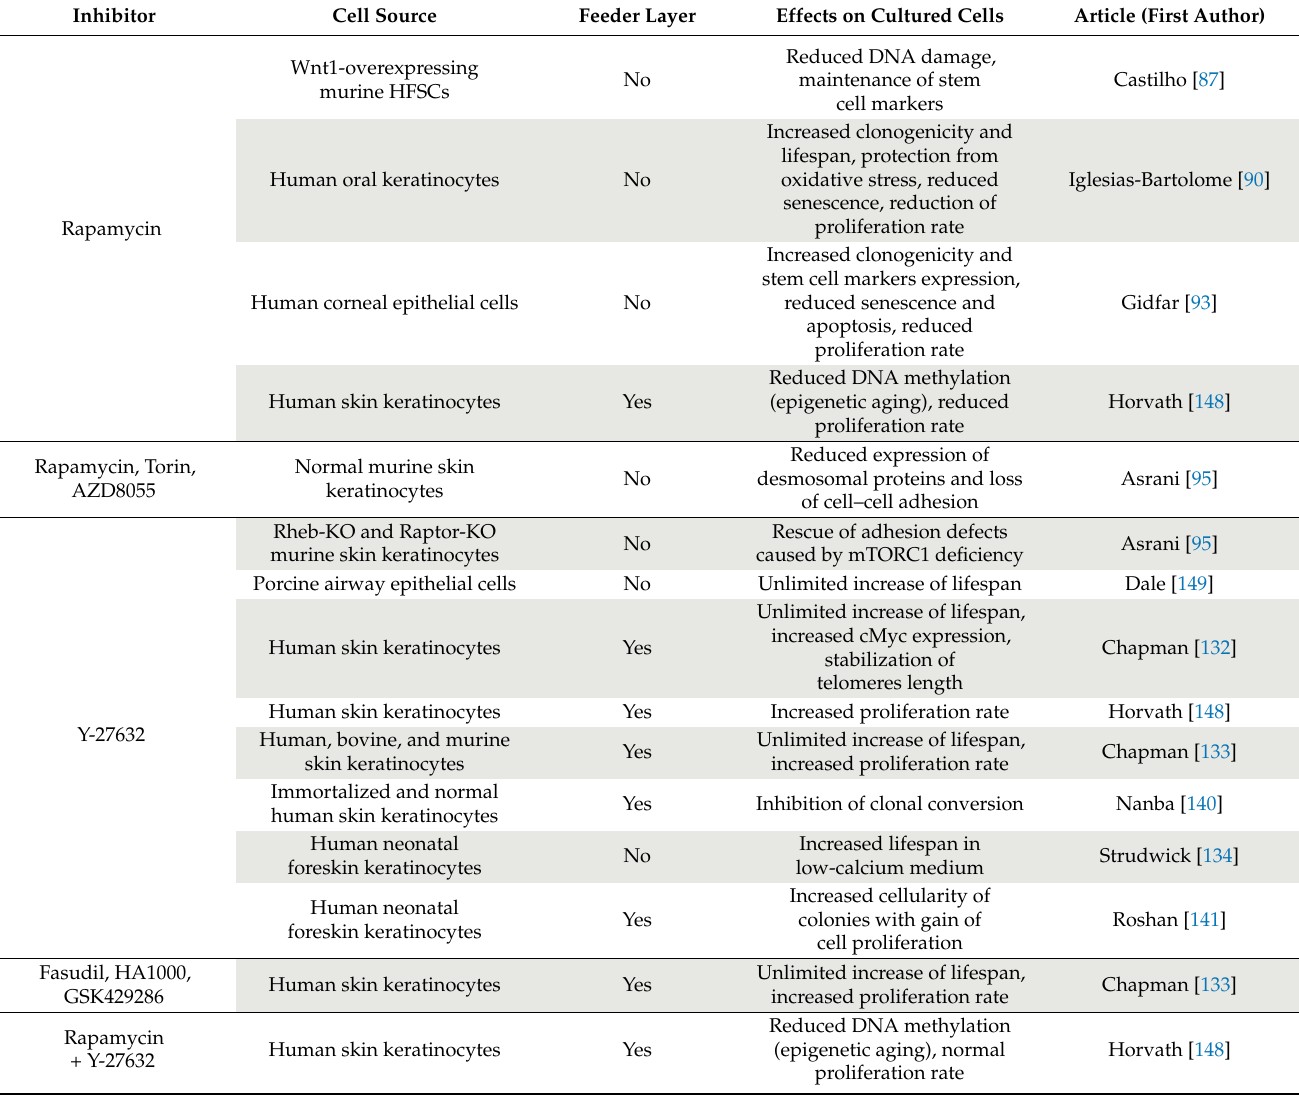
Table 1. Summary of the effects of mTOR and ROCK inhibitors in cultured